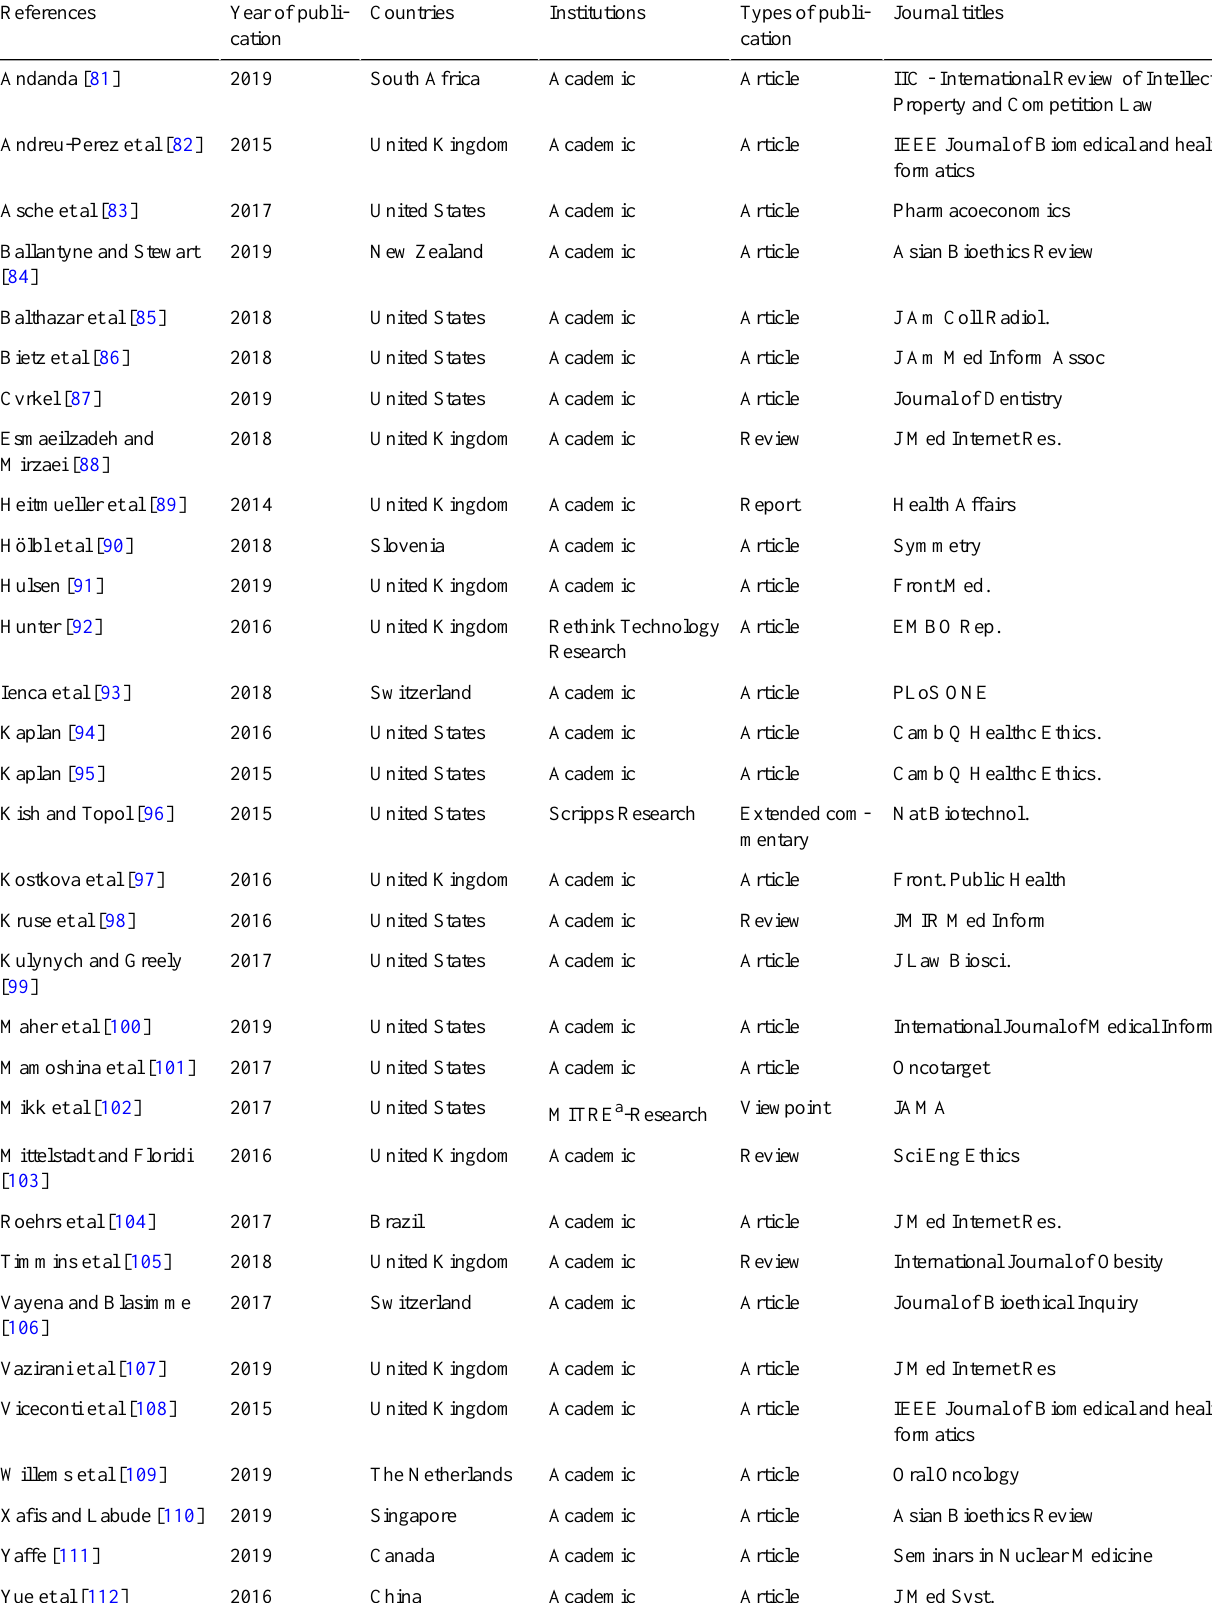
Table 2. Main general and bibliometric characteristics of the sources included in the scoping